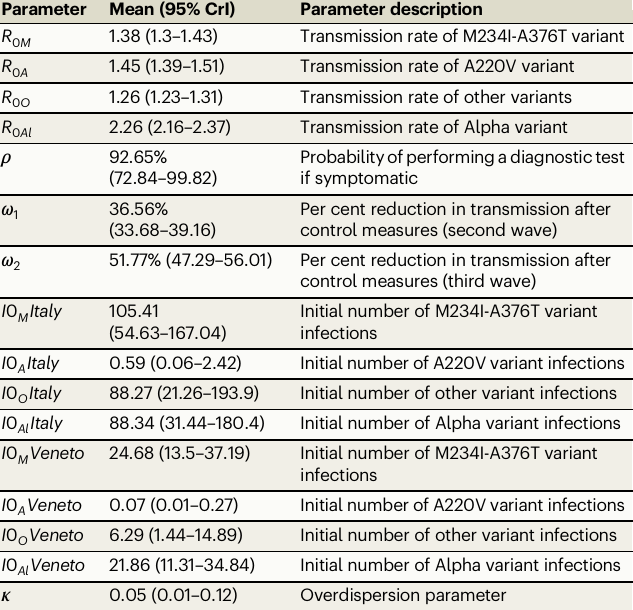
Table 2 | Mean and 95% CrI parameter estimates, obtained from the 2.5% and 97.5% percentiles of the posterior